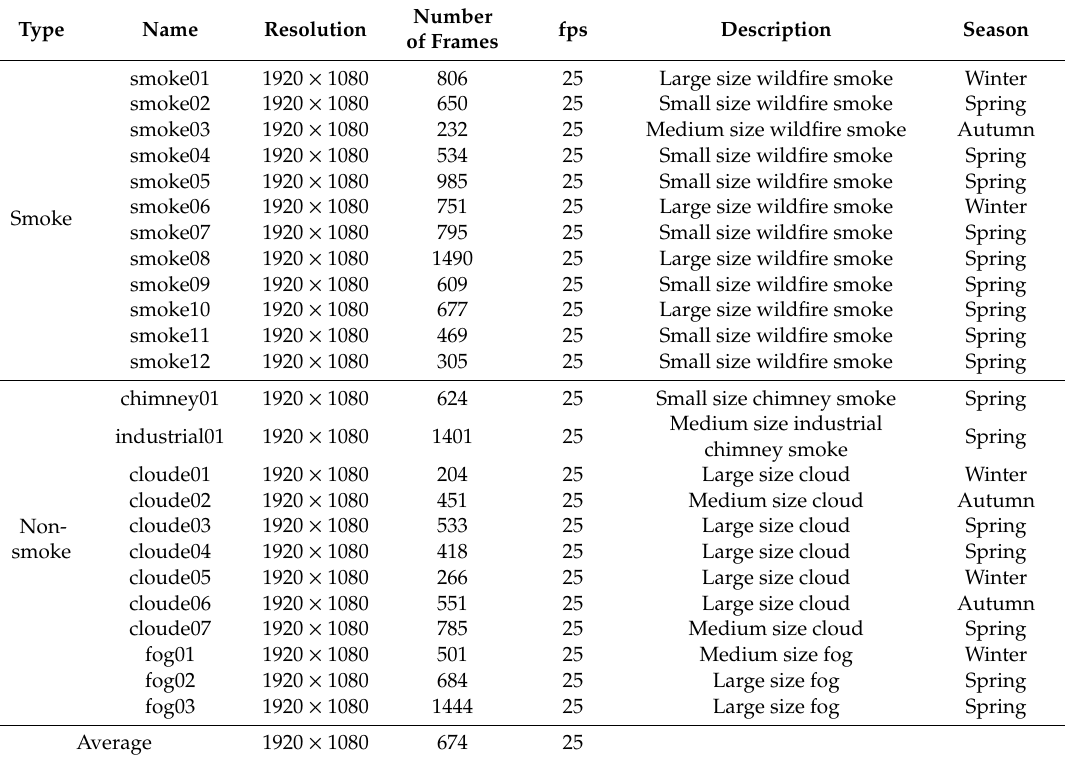
Table 1. Detailed video configuration of the test dataset 1